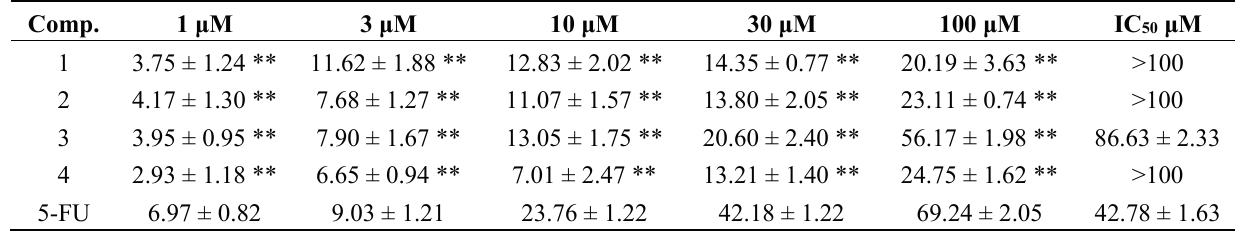
Table 3. Activities of compounds 1 – 4 on proliferation of the A549 cells.